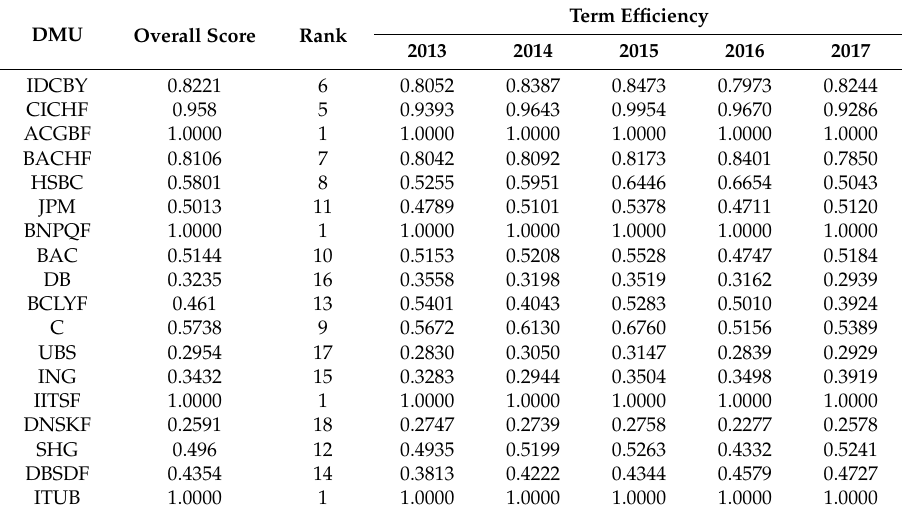
Table 2. Efficiency of large banks during the period of